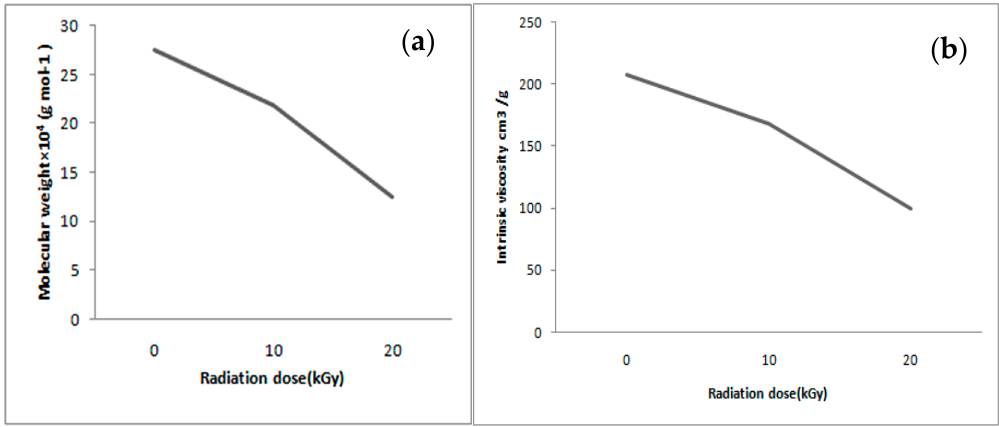
Figure 1. Effect of gamma radiation on the ( a ) Intrinsic viscosity and ( b ) molecular weight of chitosan.